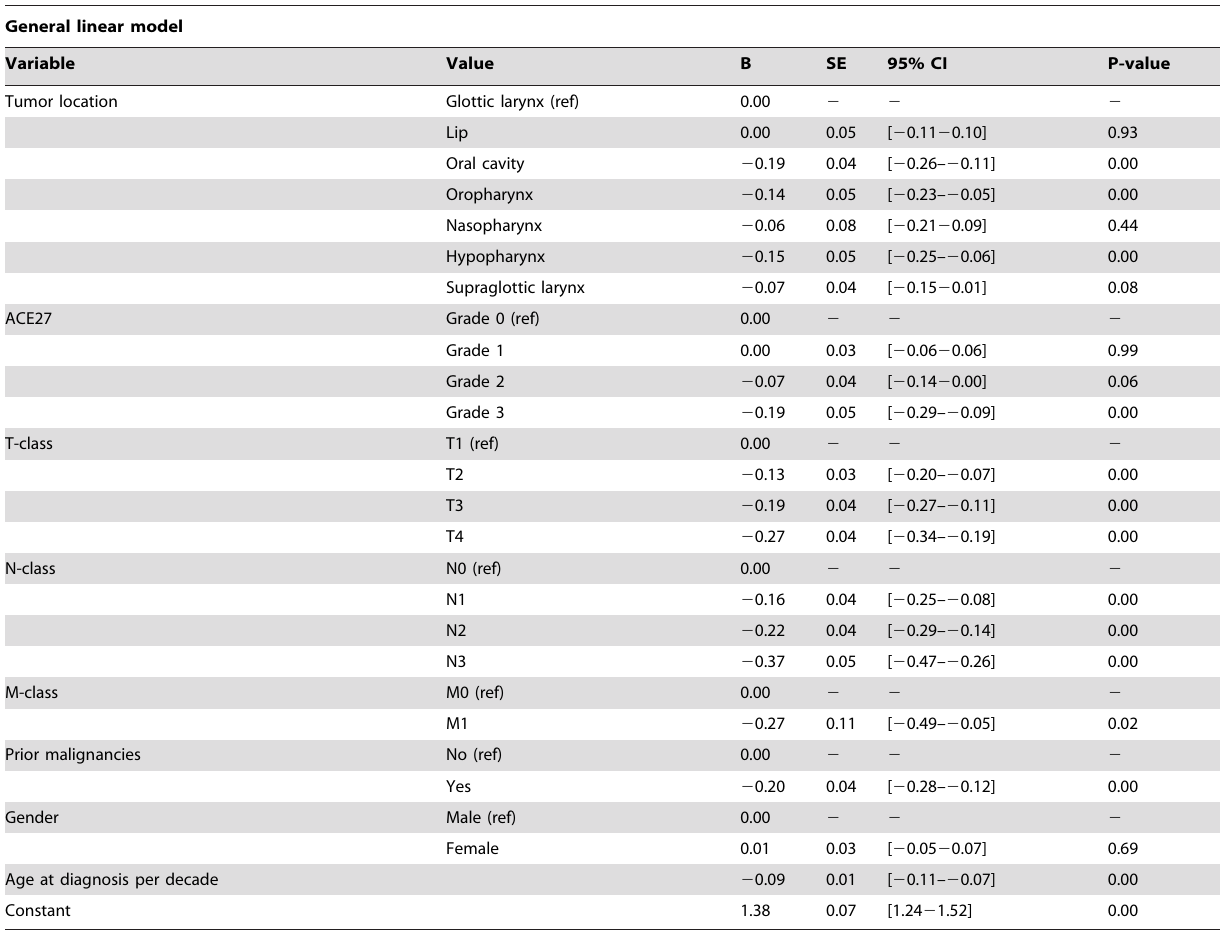
Table 8. General linear model for the outcome ‘pseudo values at 60